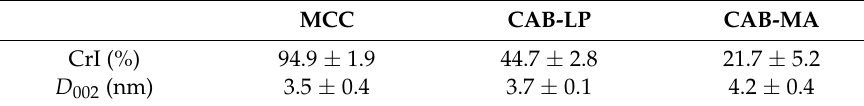
Figure 2. Typical XRD patterns of microcrystalline cellulose (MCC), CAB-LP, and CAB-MA. Table 2. Values of CrI and D 002 for MCC, CAB-LP, and CAB-MA ( n = 3).